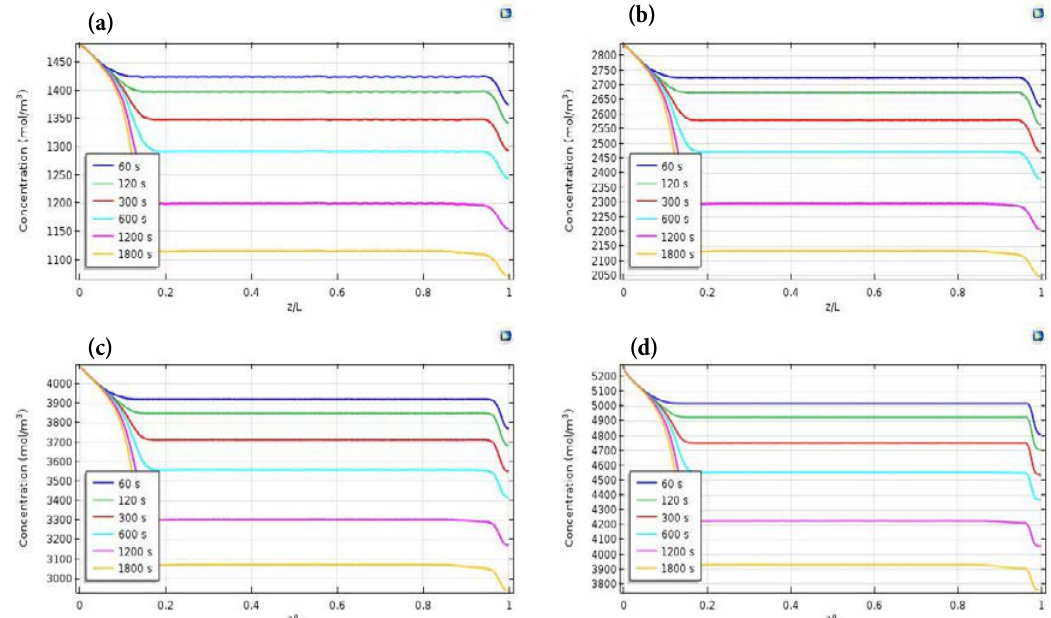
Fig. 16: Concentration distribution of water in membrane phase vs. dimensionless length at different radii (0.5 l/min flow rate and 30°C temperature); (a) r=5.5 mm, (b) r=6 mm, (c) r=6.5 mm and (d) r=R